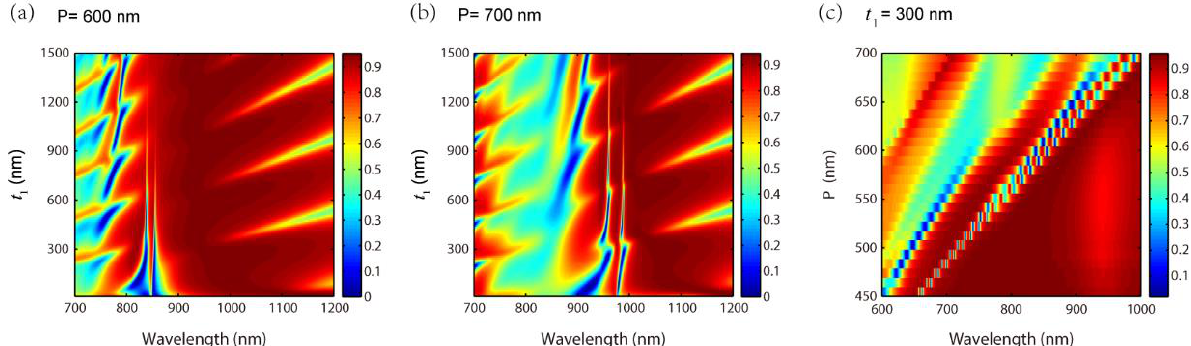
t for ( a ) and ( b ) 700 nm P  ; ( c ) Reflection spectra with different Figure 8. Reflection spectra with different Figure 8. Reflection spectra with different t 1 for ( a ) P = 600 nm and ( b ) P = 700 nm; ( c ) Reflection spectra with different P 1 for t 1 = 300 nm. P for 1